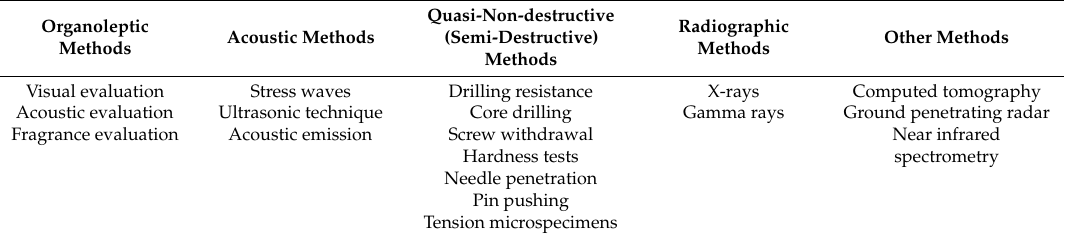
Table 2. Selected methods available for assessing timber in building